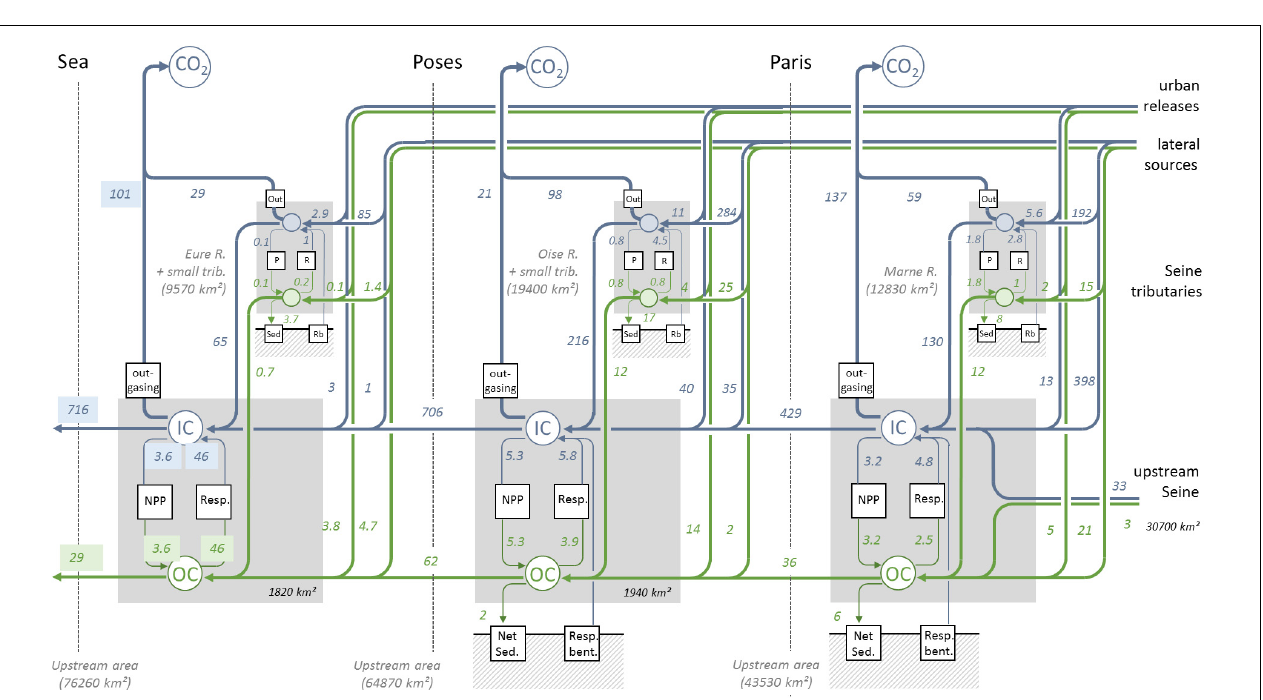
FIGURE 8 | Organic (green) and inorganic carbon budget (blue) for the Seine river network. The surface area all the different sub-sections of the watershed are indicated in italic.